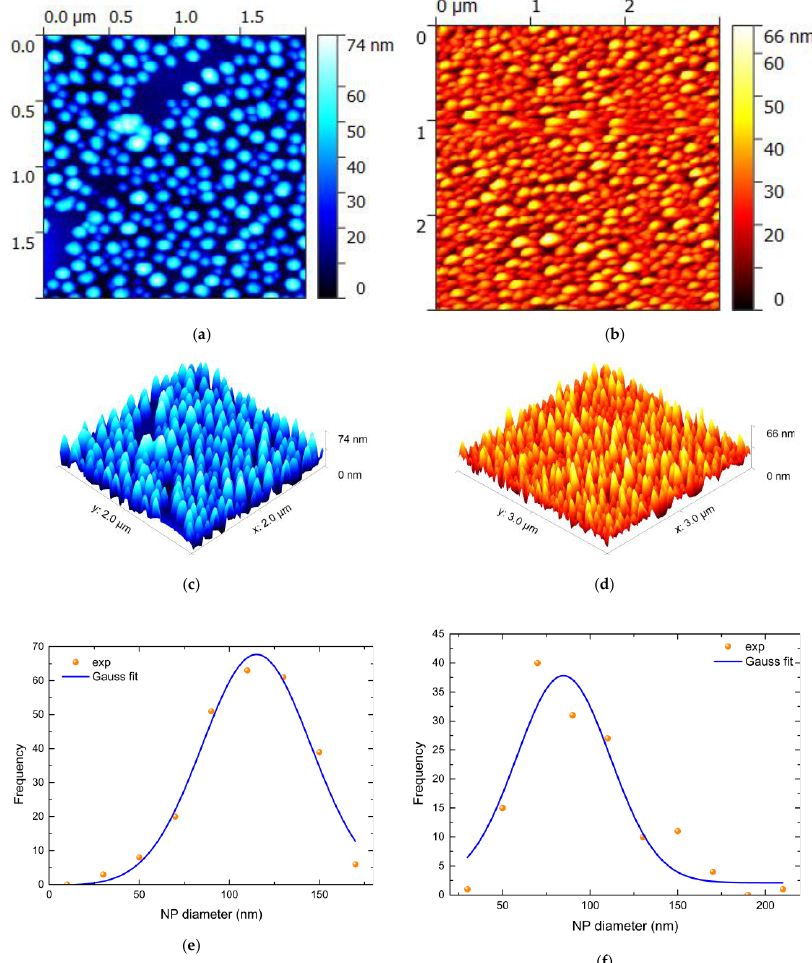
Figure 13. Two- and three-dimensional AFM images and nanoparticle size distribution diagrams ( a , c , e ) for the area of the AgPd #1 (7.5 nm) multilayer that was thermally annealed at 460 °C for 5 min, and ( b , d , f ) for the area of the same multilayer that was laser-annealed with 20 passes.